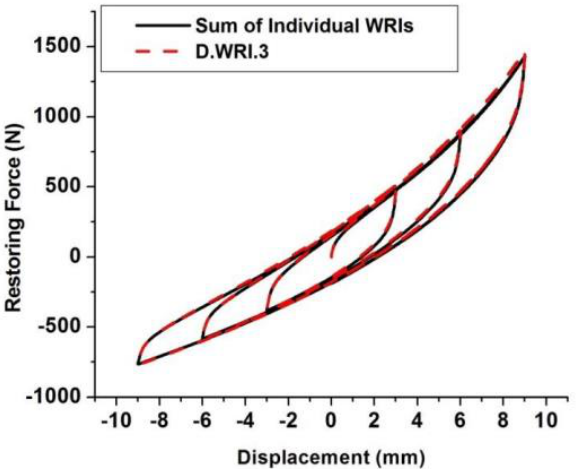
Figure 11. Comparison of sums of individual WRIs with D − WRI. Table 8. Effective stiffness and effective damping in the roll direction.